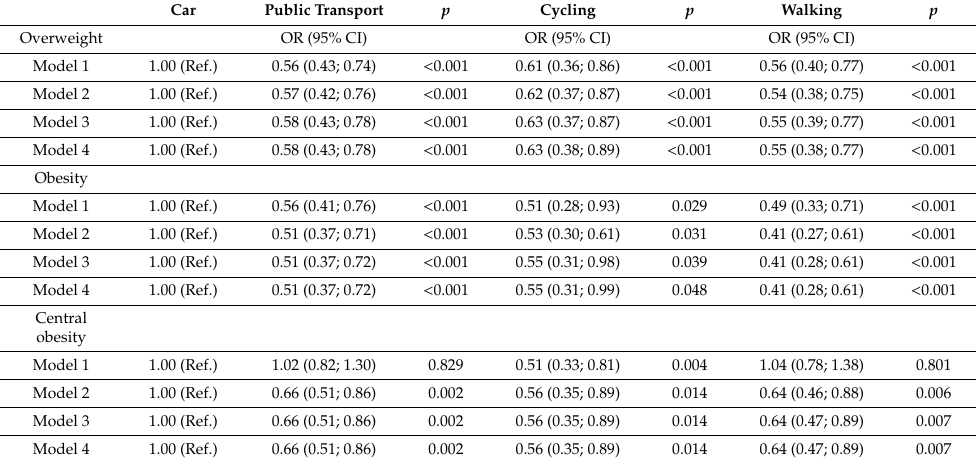
Table 3. Association between travelling mode and obesity.